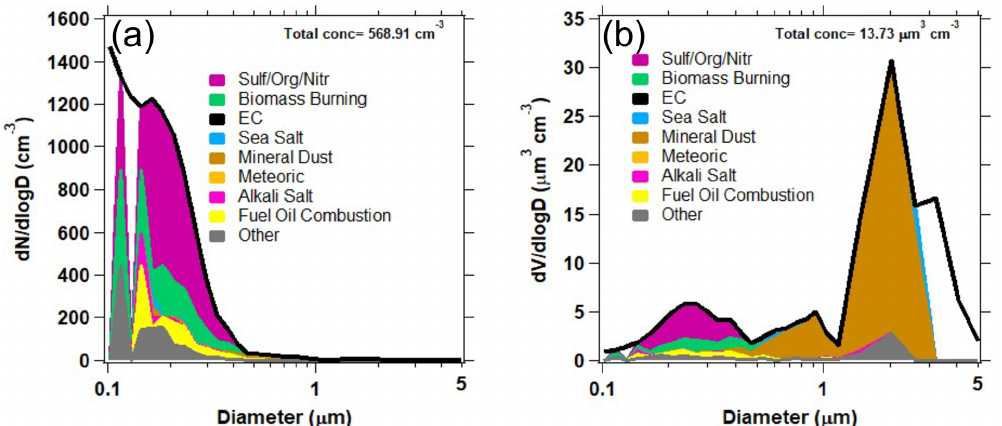
Figure A7. PALMS particle classes are mapped to the total number (a) and volume (b) size distribution from LARGE based on the method of Froyd et al. (2019). Data include flight segments representative of the polluted dust